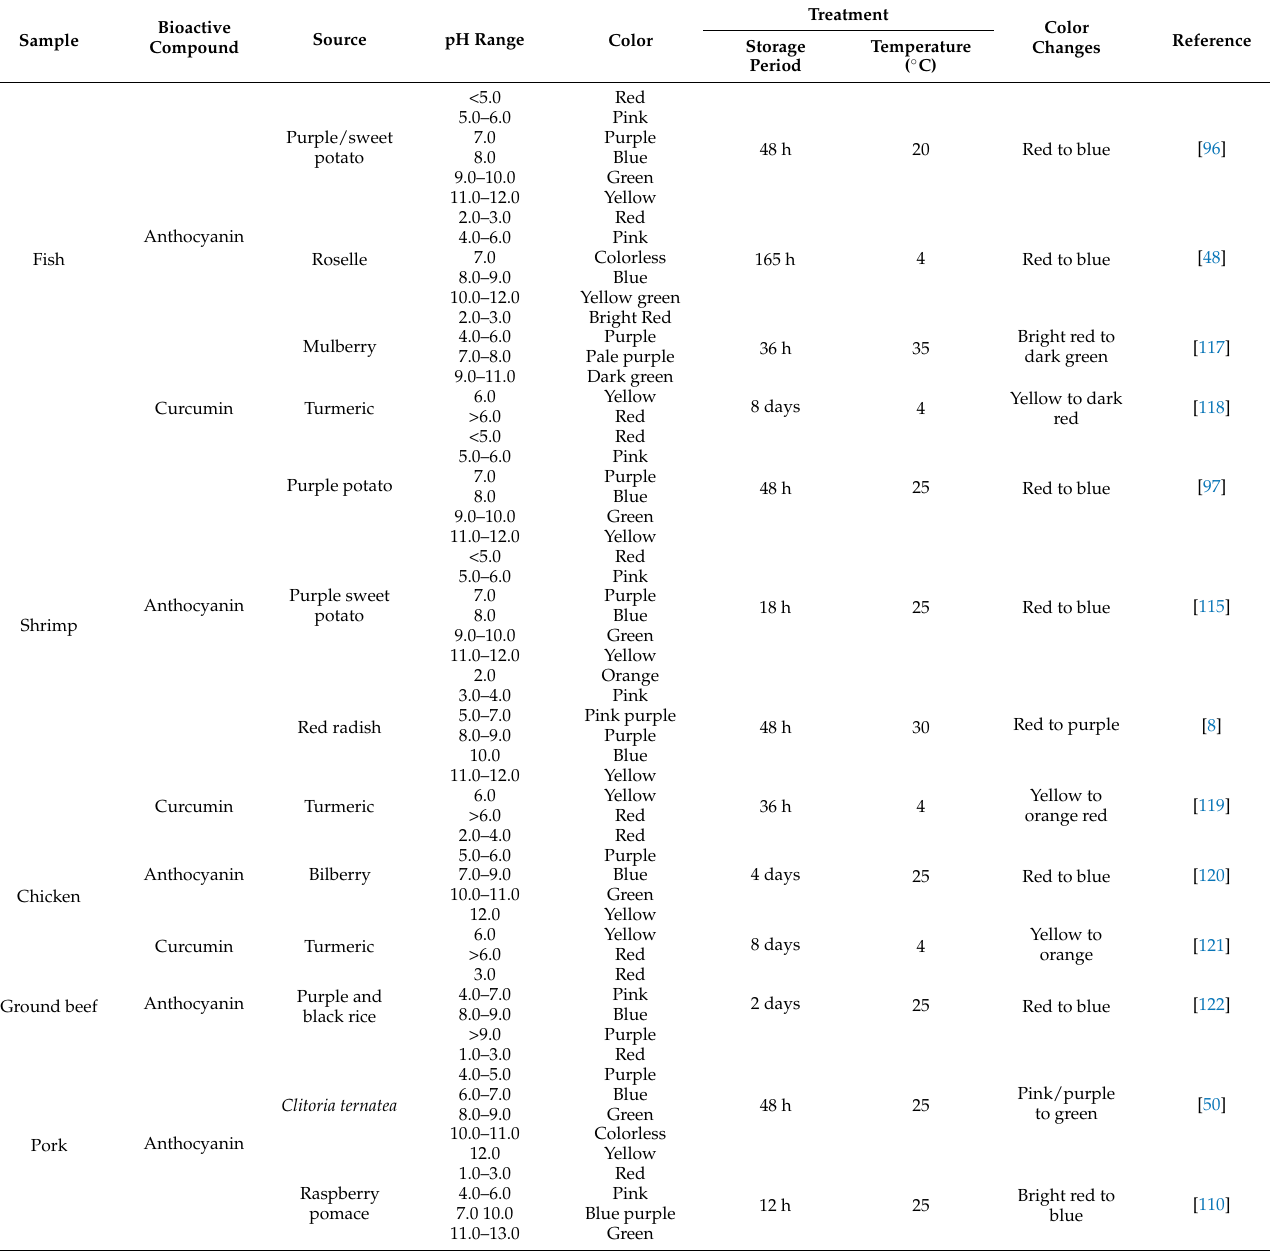
Table 2. pH range of film packaging as a color indicator from various sources of natural extract and application on meat spoilage